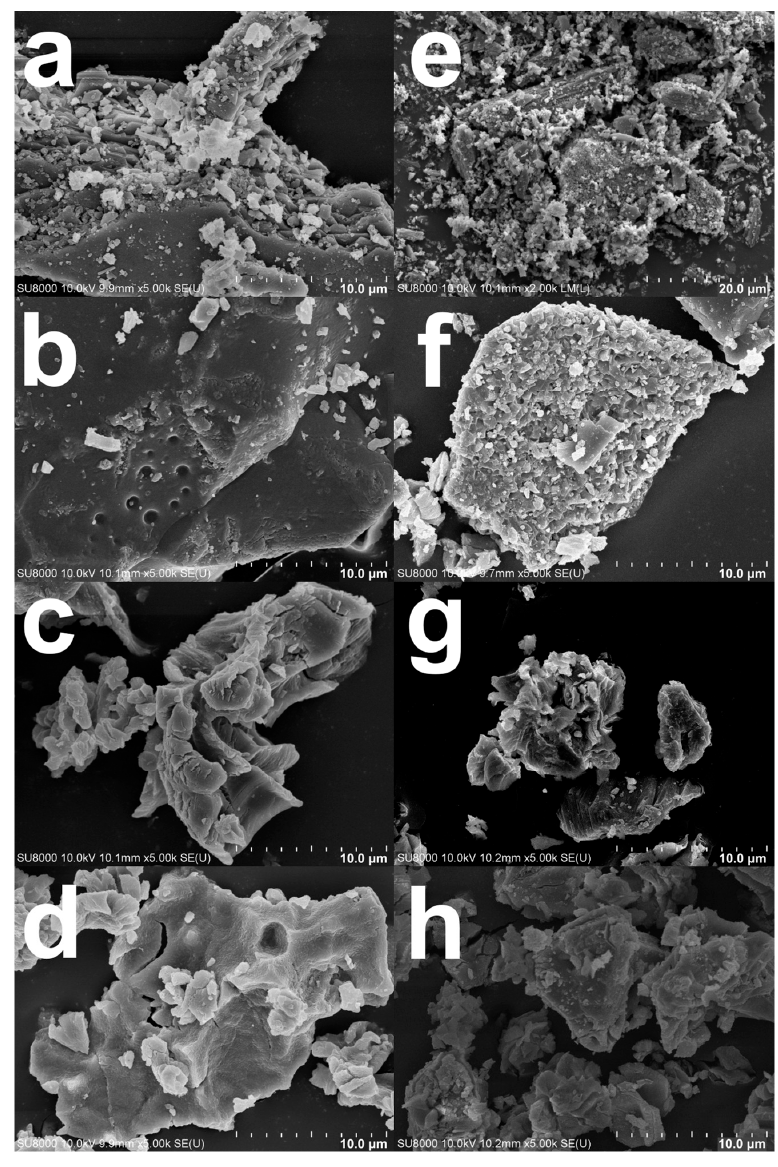
Figure 6. The SEM images of ( a ) green mussel shells without calcination; calcined green mussel shells for 3 h at ( b ) 800 °C, ( c ) 900 °C, and ( d ) 1000 °C; ( e ) mixed shell powder without calcination; and calcinated mixed shell powder for 2 h at ( f ) 800 °C, ( g ) 900 °C, and ( h ) 1000 °C. According to XRD spectra (Figure 4), CaO alone was detected in green mussel shells and mixed shell powder calcined at 1000 °C for 3 h and 2 h, respectively. Therefore, we investigated the CaO structure of both waste shell samples using SEM after calcining at 1000 °C. The sizes of various particles are at the nanoscale level are demonstrated in Figure 7. Similar structures of CaO nanoparticles from natural seashell waste, Lottioidea reticularis , after calcination at 900 °C for 4 h were reported by Anand et al. [19]. The appearance of CaO agglomeration of round particles in the range of nanoscales located at the surface was also detected in different types of mussel waste shells, reported by Laonapakul et al. [33]. The comparison between green mussel shells and mixed shell powder after calcina- tion at 1000 °C shows that more regular particles are present in the mixed shell powder (Figure 7b) than those in green mussel shells (Figure 7a), although mixed shell powder